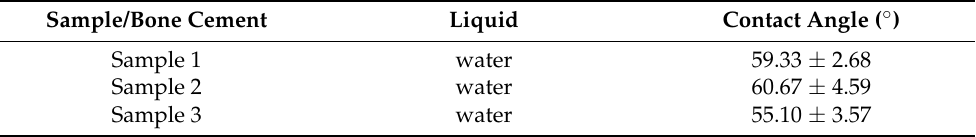
Table 3. Contact angle values for the experimental samples.